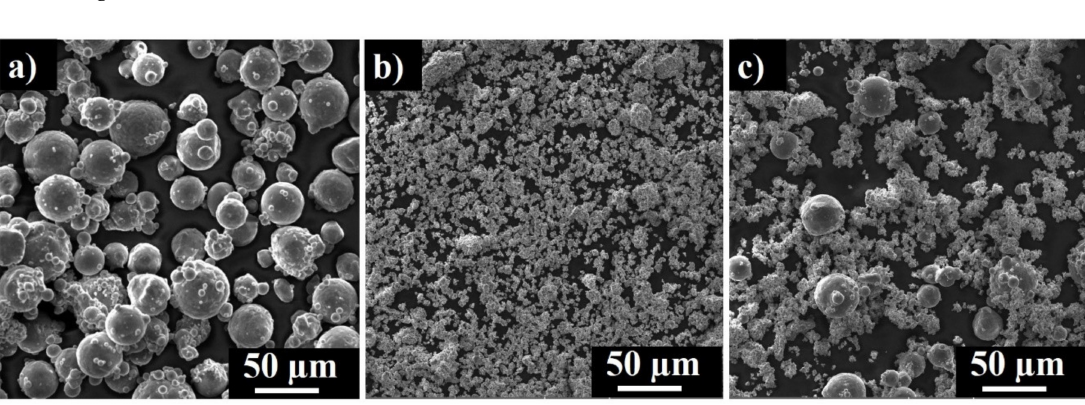
Figure 2. SEM images of AlSi10Mg alloy ( a ), MoSi 2 ( b ), and MoSi 2 -30 wt.% AlSi10Mg powder mixture ( c